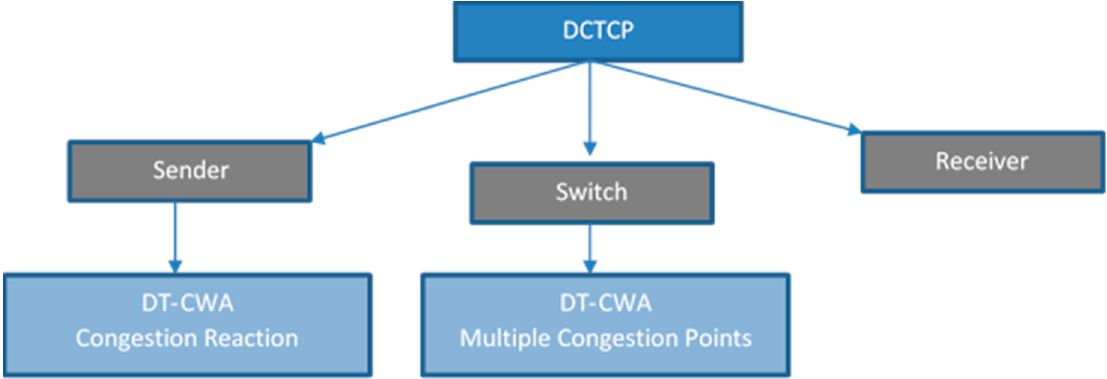
Figure 2. Double threshold and congestion reaction using window adjustment (DT-CWA) modifications over DCTCP.